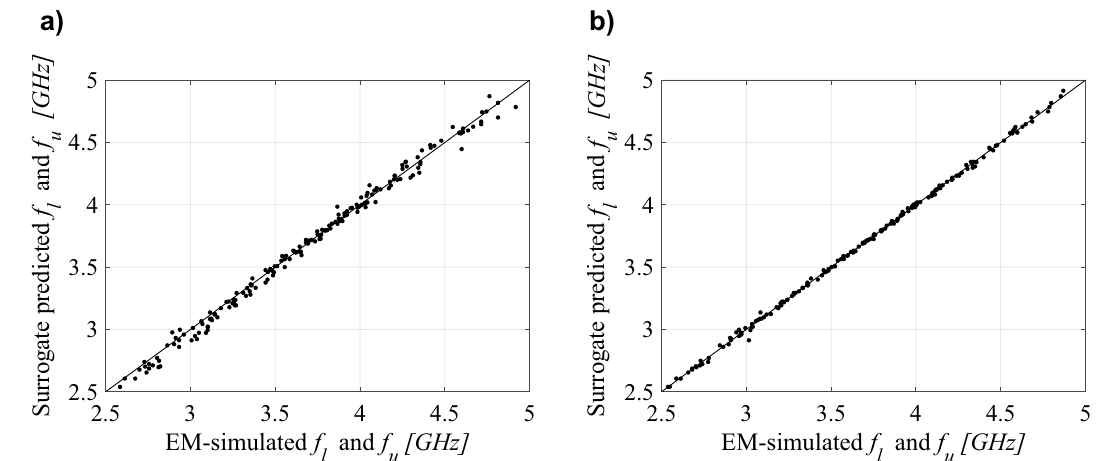
Figure 7. Quasi-Yagi antenna of Fig. 4c: scatter plots of the lower and upper frequencies corresponding to − 10 dB reflection levels [GHz] yielded by the proposed surrogate against their EM-simulated counterparts; surrogates constructed using ( a ) N B = 20 and ( b ) N B = 100